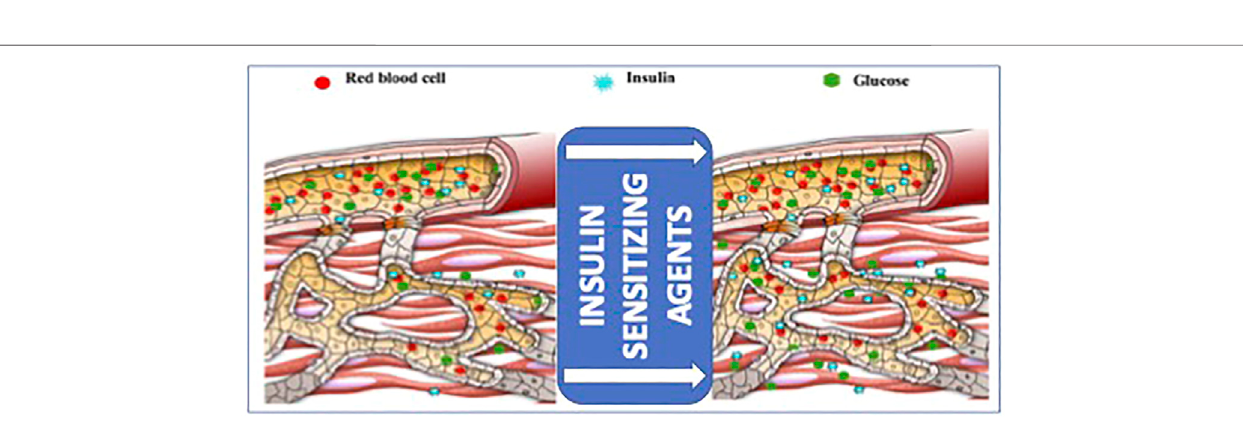
Frontiers in Bioengineering and Biotechnology |